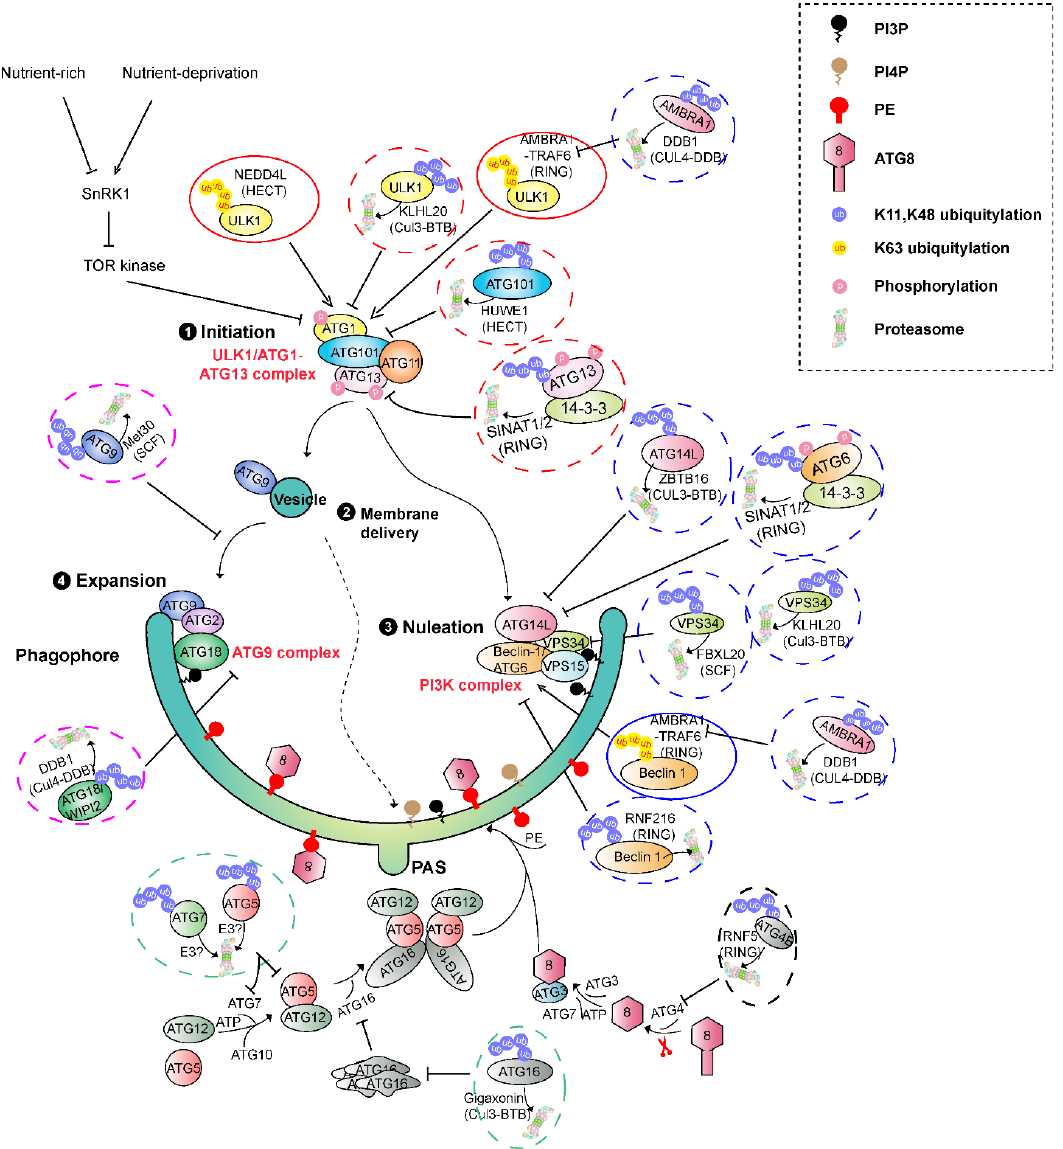
Figure 4. A schematic diagram showing the structural assembly of phagophore and UPS-mediated stability control. Please refer to the text for the detailed process of phagophore initiation, nucleation, and expansion. The UPS-mediated stability control of each component is also described in the text. In plants, two mono-subunit RING E3 ligases, SEVEN IN ABSENTIA of Arabidopsis thaliana (SINAT1,2), have been discovered to target the ubiquitylation and degradation of Table 1. List of ATG proteins identified as a UPS ATG13 under nutrient-rich conditions [136]. Upon the degradation of ATG13, the ATG1- ATG13 complex is destabilized, thus terminating autophagy. On the contrary, SINAT6, a RING-truncated SINAT paralog with no ubiquitin E3 ligase activity, stabilizes the ATG1- ATG13 complex by competing SINAT1/2 for binding with ATG13 through the TRAF do- main [136]. Further studies of the same group showed that two additional ATG13-inter- acting proteins, 14-3-3 and 14-3-3 , are involved in the turnover of ATG13 [137]. Under nutrient-rich conditions, phosphorylation of ATG13 by TOR facilitates its association with 14-3-3 proteins, which promotes the recruitment of SINAT1/2 for ubiquitination and